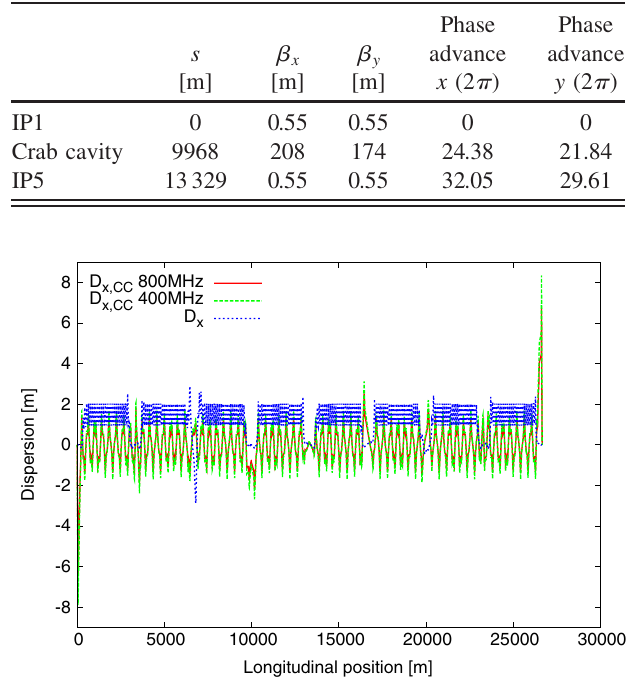
FIG. 1. (Color) Crab dispersion and off-momentum dispersion for nominal LHC optics.